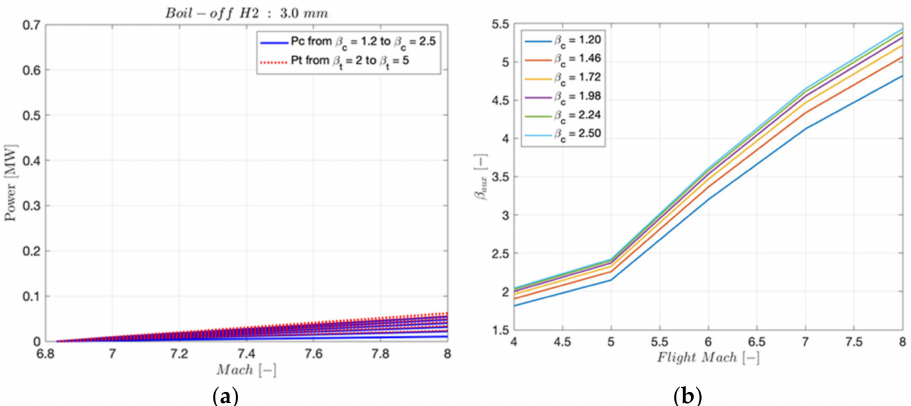
Figure 27. ( a ) Variation of the available (turbine) vs. required (compressor) power of the CAU with Mach number for 3 mm thick boil-off hydrogen insulation layer; ( b ) variation of the compression ratio of the auxiliary compressor with the Mach number for different values of the compression ratio of the CAU’s compressor.